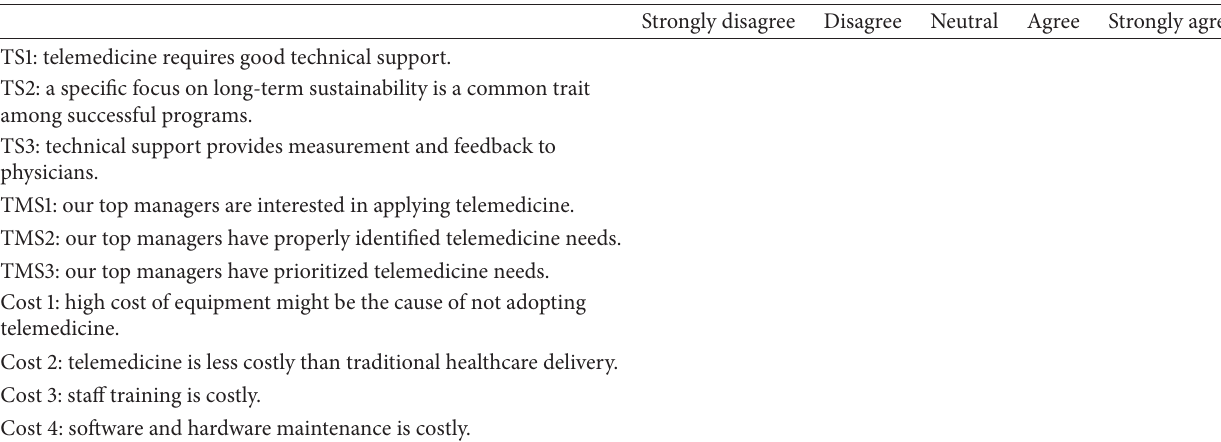
Table 7: Part 5: organization